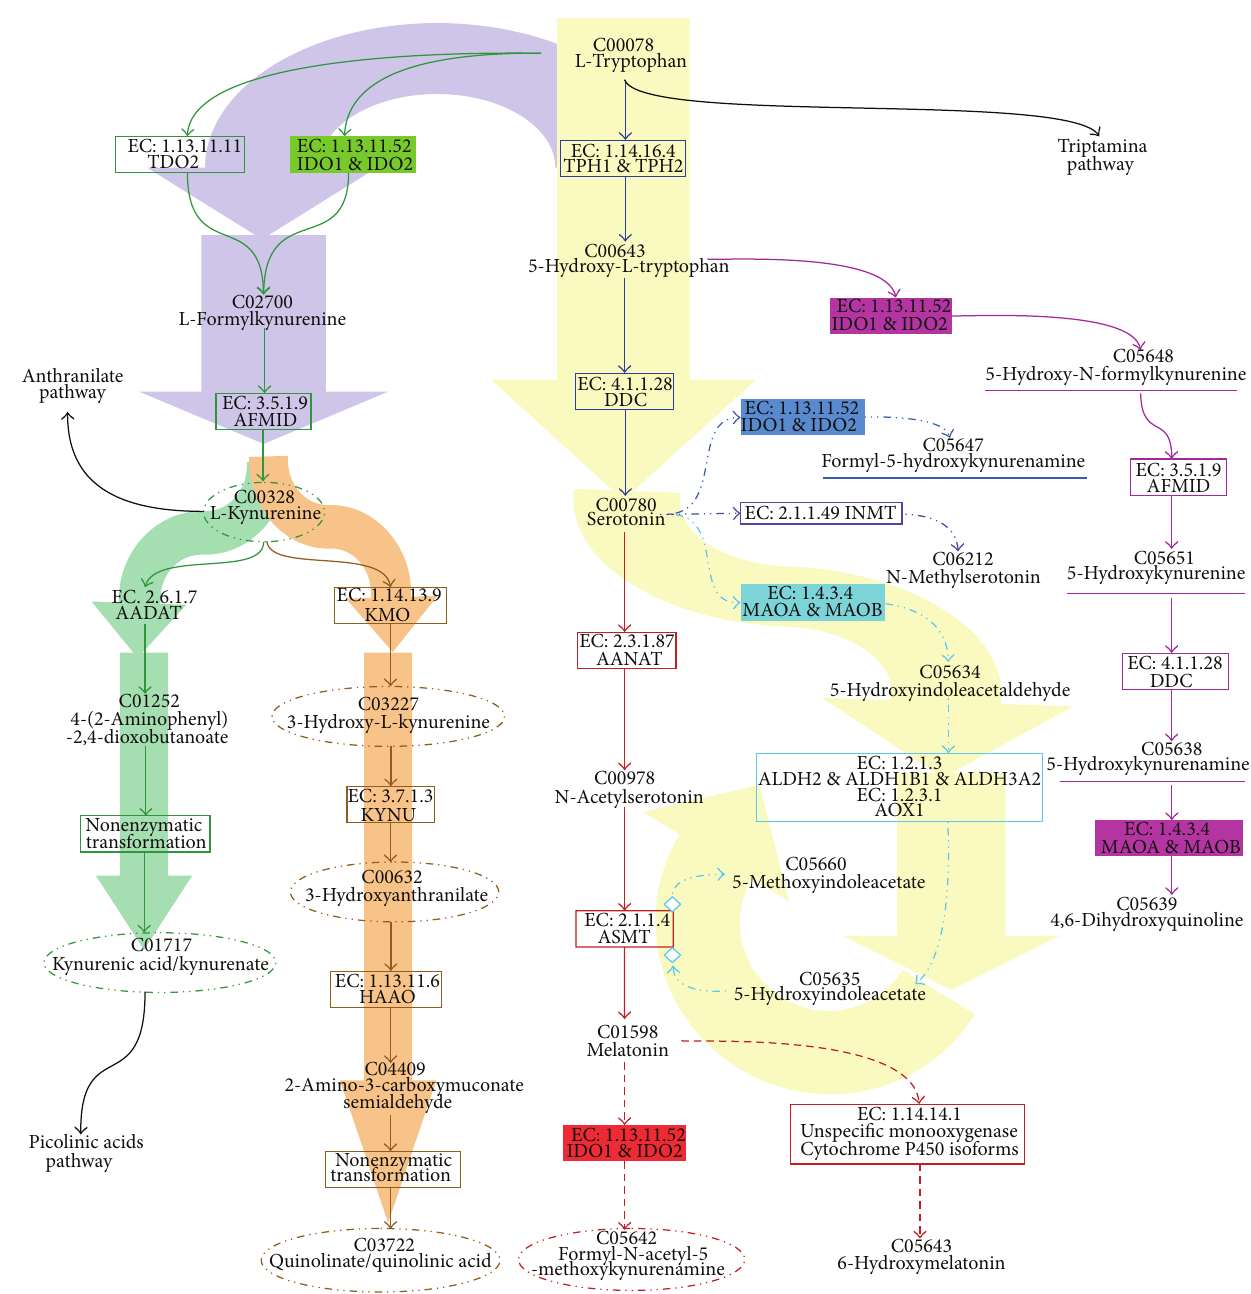
Figure 1: Metabolic pathways associated with 5-HT. The metabolic pathways branching from the catabolism of tryptophan are shown. Green and brown branches show kynurenine pathways from tryptophan. The dark blue branch displays the 5-HT generation pathway while the red branch displays the melatonin generation pathway (solid line) and the melatonin catabolism pathway (dashed lines). The 5- HT catabolism pathways are depicted in blue, purple, and cyan dotted lines. The most relevant compounds are circled with dotted lines and underlined compounds have no demonstrated effects. An additional catabolic pathway marked in pink from 5-hydroxy-L-tryptophan generates 5-hydroxy-kynurenine and 5-hidroxy-kynurenamine family compounds (paths C05648 and C05647), which have no demonstrated biological effects. The compounds in these pathways are denoted by their “Kyoto Encyclopedia of Genes and Genomes” (KEGG) code (http://www.genome.jp/kegg/). Enzymes with their classification codes (EC, http://www.chem.qmul.ac.uk/iubmb/enzyme/) and UNIPROT gene names are shown in squares. The shading arrows show the most studied